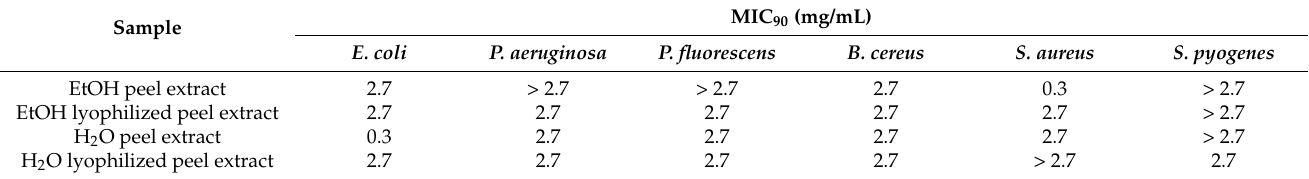
Table 5. Minimum inhibitory concentrations (MIC 90 ) for P. granatum extracts on various bacteria. Sample